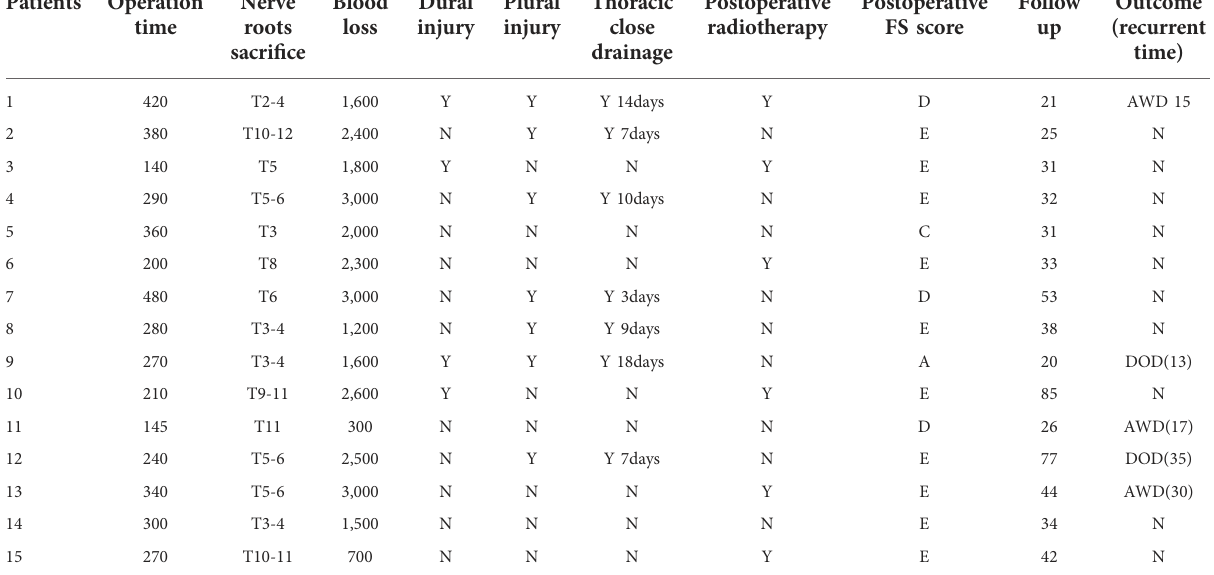
T, Thoracic vertebrae; L, Libs; LOM, limitation of movement. TABLE 2 Surgery and outcomes.